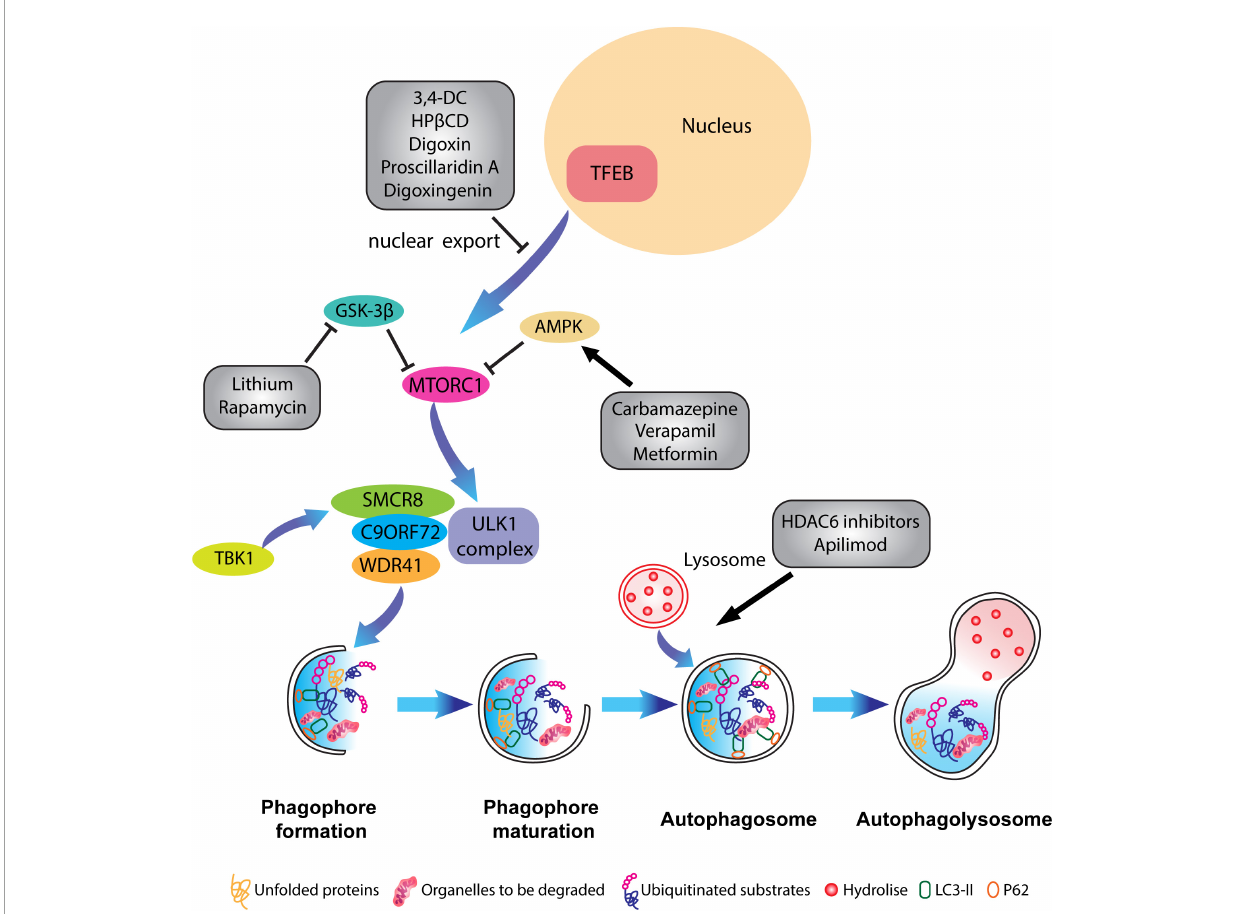
FIGURE4 Pharmacological targeting of the autophagy pathway in neurons. Schematic representation of different compounds that have been used to alleviate ALP impairments and to restore autophagic flux. Some therapeutical agents promote the activation or inhibition of specific kinases which block mTORC1 activity such as Carbamazepine, Verapamil and Metformin, or inhibit the translocation of TFEB from the nucleus to the cytoplasm like in the case of 3,4-dimethoxychalcone (3,4-DC), 2-Hydroxypropyl- β -cyclodextrin (HP β CD), Digoxin, proscillaridin A. Other molecules such as HADC6 inhibitors and apilimod promote the fusion of lysosomes with the